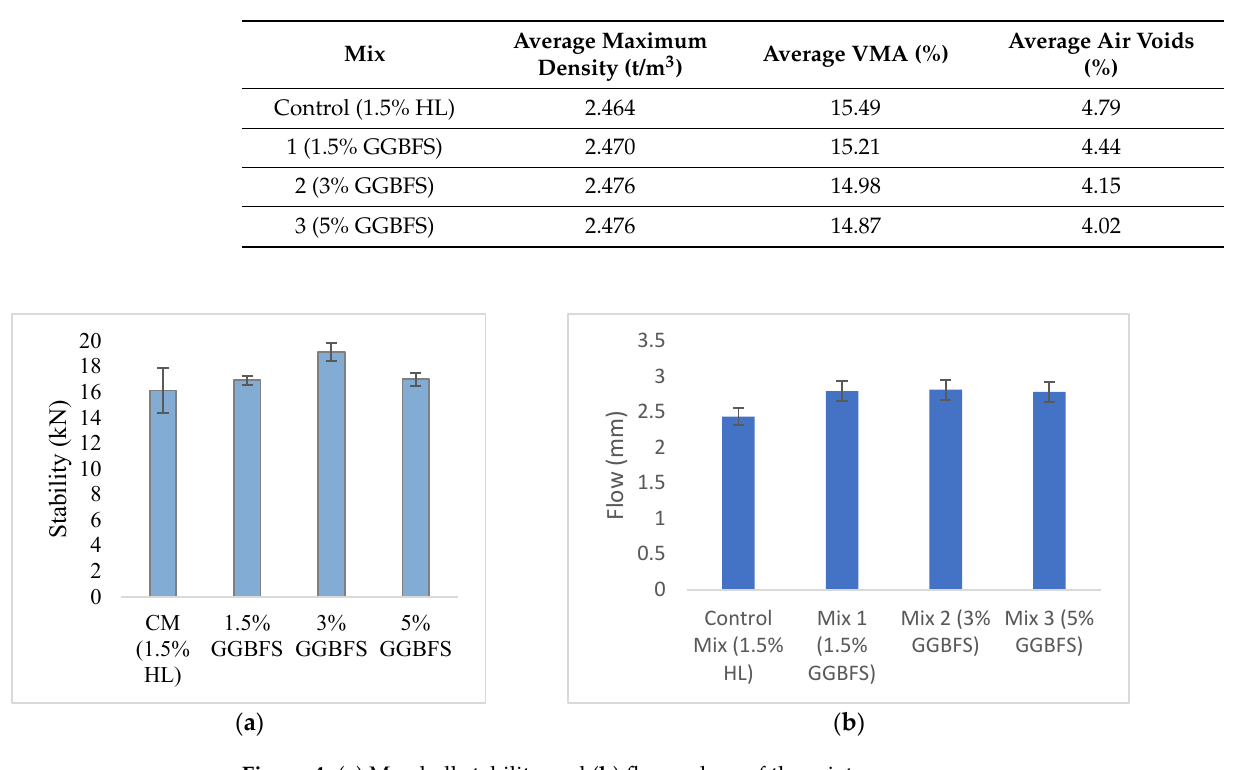
Table 10. Fatigue test results.